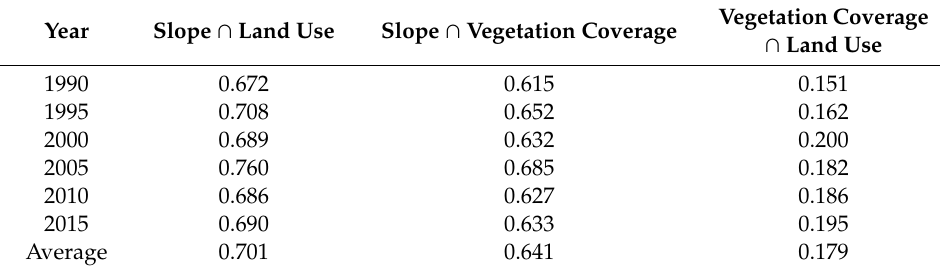
Table 4. The q values of the three dominant interaction factors in the